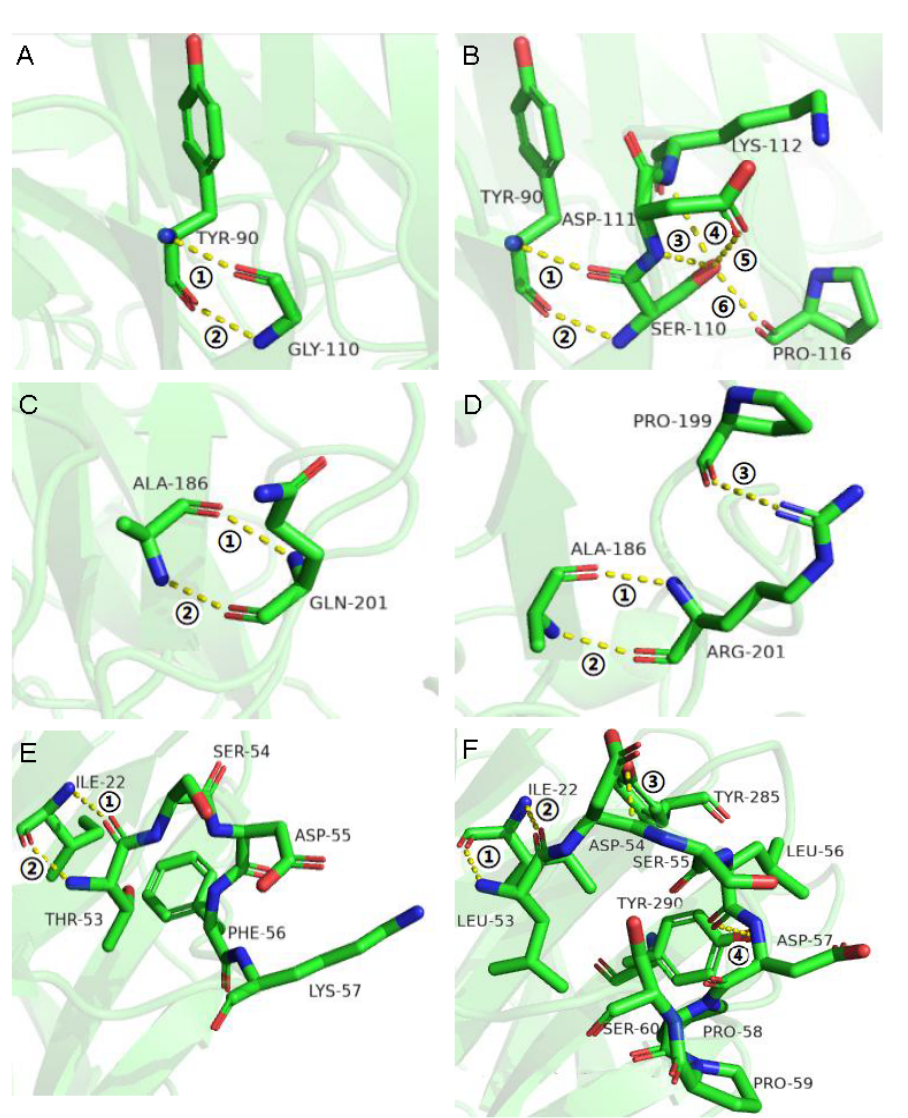
Figure 5. Structural comparison between wild type AX543 and the mutants G110S, Q201R, and L2. ( A ) G110 of AX543; ( B ) S110 of mutant G110S; ( C ) Q201 of AX543; ( D ) R201 of mutant Q201R; ( E ) Loop2 of AX543; ( F ) Loop2 of mutant L2. The yellow dotted line represents the hydrogen bonds. The different hydrogen bonds were marked with 1 (cid:13) , 2 (cid:13) , 3 (cid:13) , 4 (cid:13) , 5 (cid:13) , 6 (cid:13)